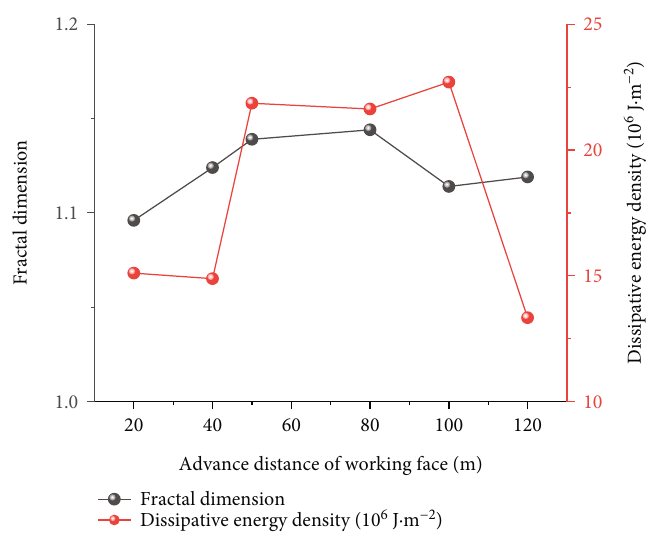
Figure 5: Energy versus fractal dimension curve.